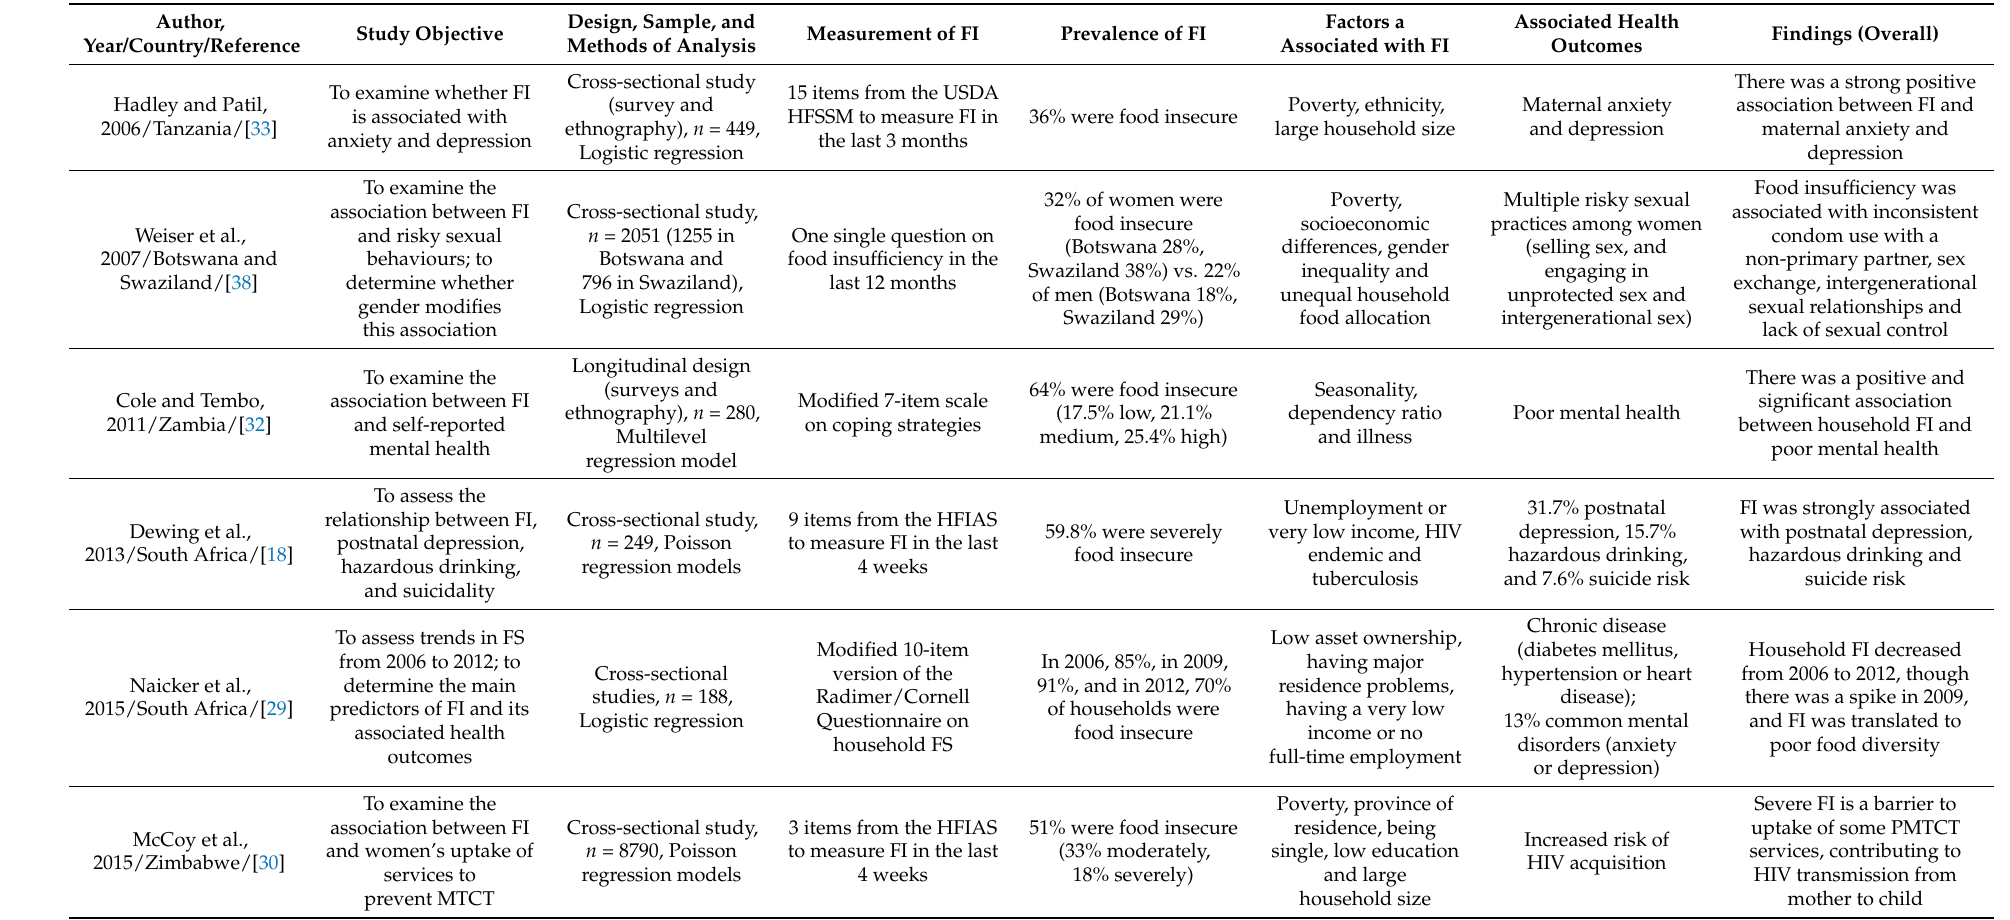
Table 1. Summary of the 14 studies included in the systematic